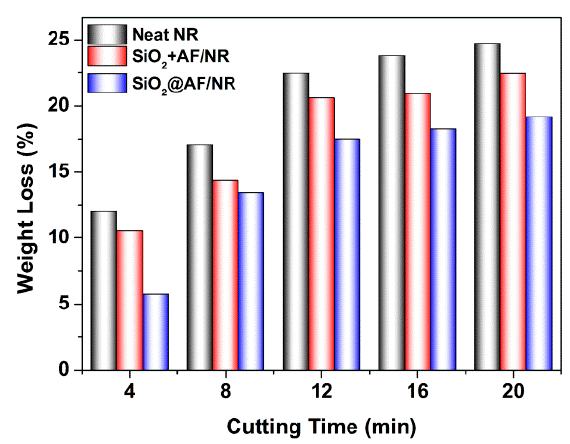
Figure 10. Weight loss versus cutting time for neat NR, SiO 2 + AF / NR and SiO 2 @AF / NR composites.